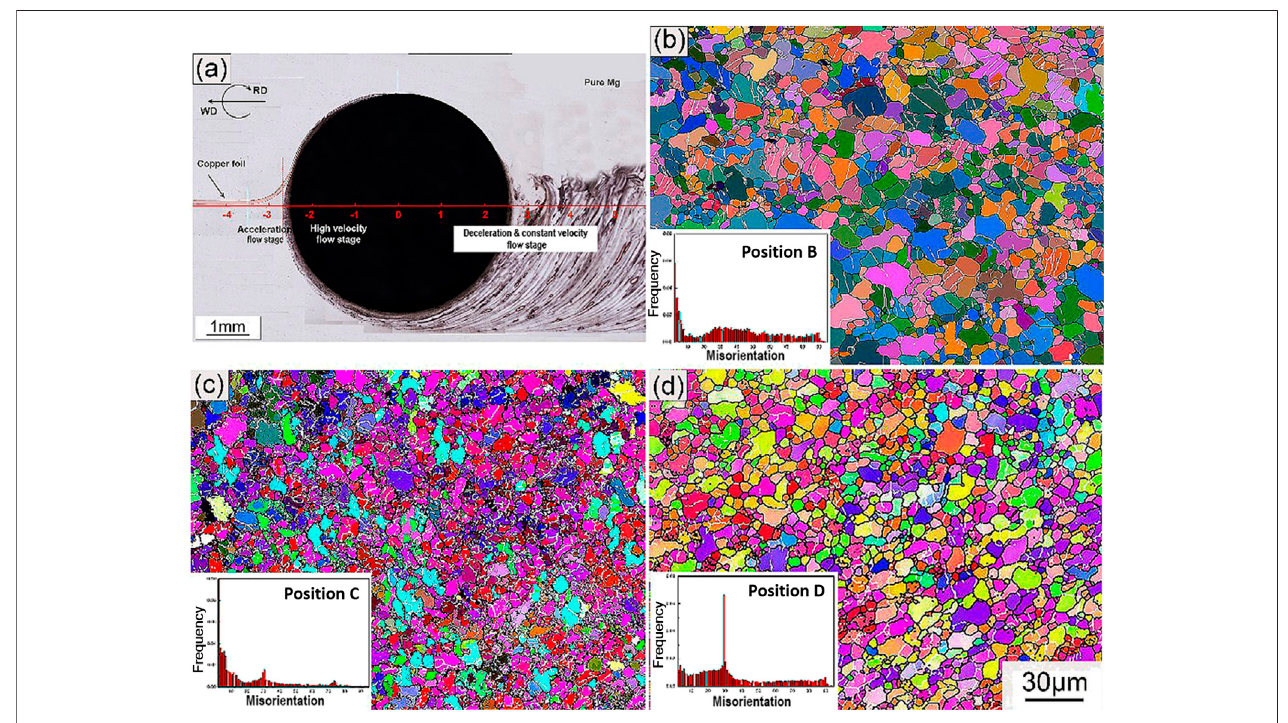
FIGURE 9 | Results of the experiments of the plates FSWed with 1,500 rpm. (A) Metallographic photo of the “ stop action ” ; (B) Microstructure at position B; (C) Microstructure at position C; and (D) Microstructure at position D.